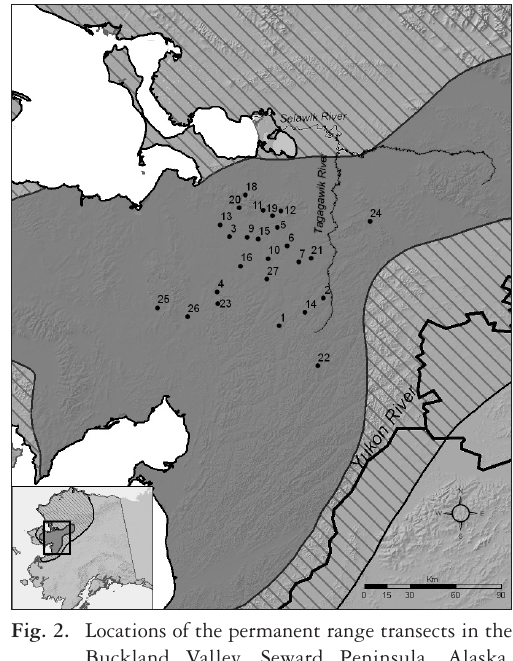
Fig. 1. Range of the Western Arctic Herd, 1981 – 2005, northwestern Alaska. Year-round distribution is hatched and core winter range is colored dark gray. Distribution is based on Alaska Department of Fish and Game data.